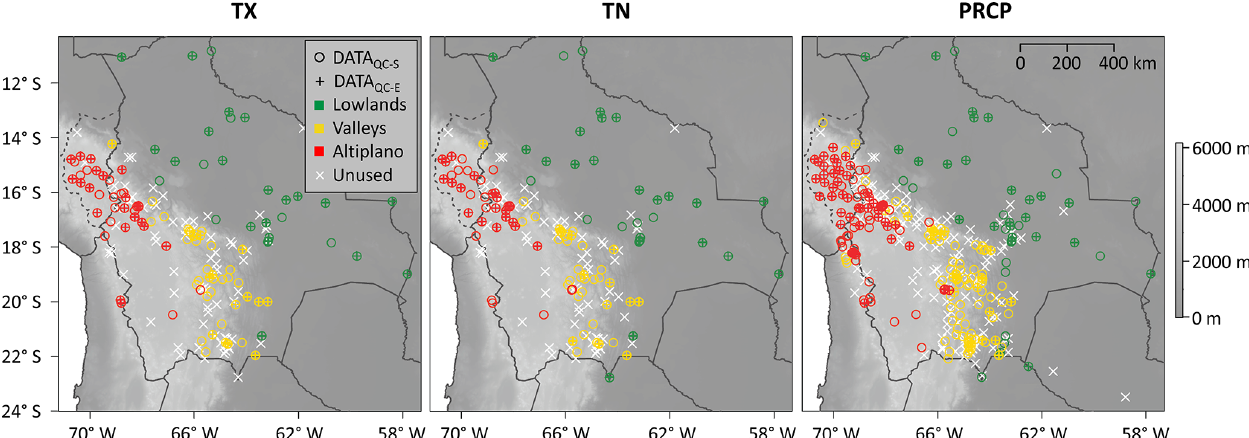
Figure 1. Stations of the DECADE dataset with ≥ 20 years of valid observations for maximum temperature (TX), minimum temperature (TN), and precipitation (PRCP). Solid lines represent country borders, and the dashed line is the border of the Peruvian department of Puno. Circles and pluses indicate stations with ≥ 80% of valid measurements from 1981 to 2010 in the datasets quality controlled with a standard method (DATA QC-S ) and with an enhanced approach (DATA QC-E ), respectively. White crosses mark stations with < 80% of valid observations from 1981 to 2010 in both datasets. Colours classify stations regarding their elevation in lowlands ( ≤ 600ma . s . l . ), valleys (601 to 3499ma . s . l . ), and Altiplano ( ≥ 3500ma . s . l . ). The grey background shading indicates the elevation in m